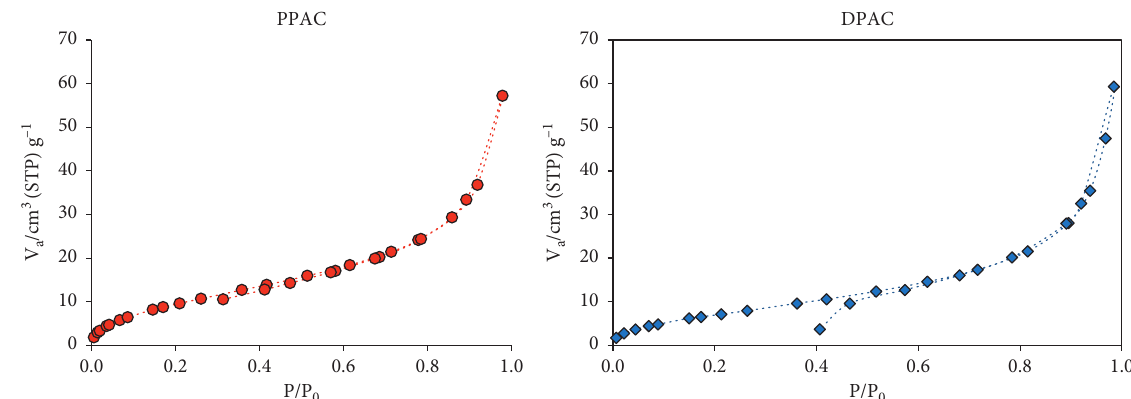
Figure 4: N 2 sorption-desorption isotherms of prepared nanocomposites.